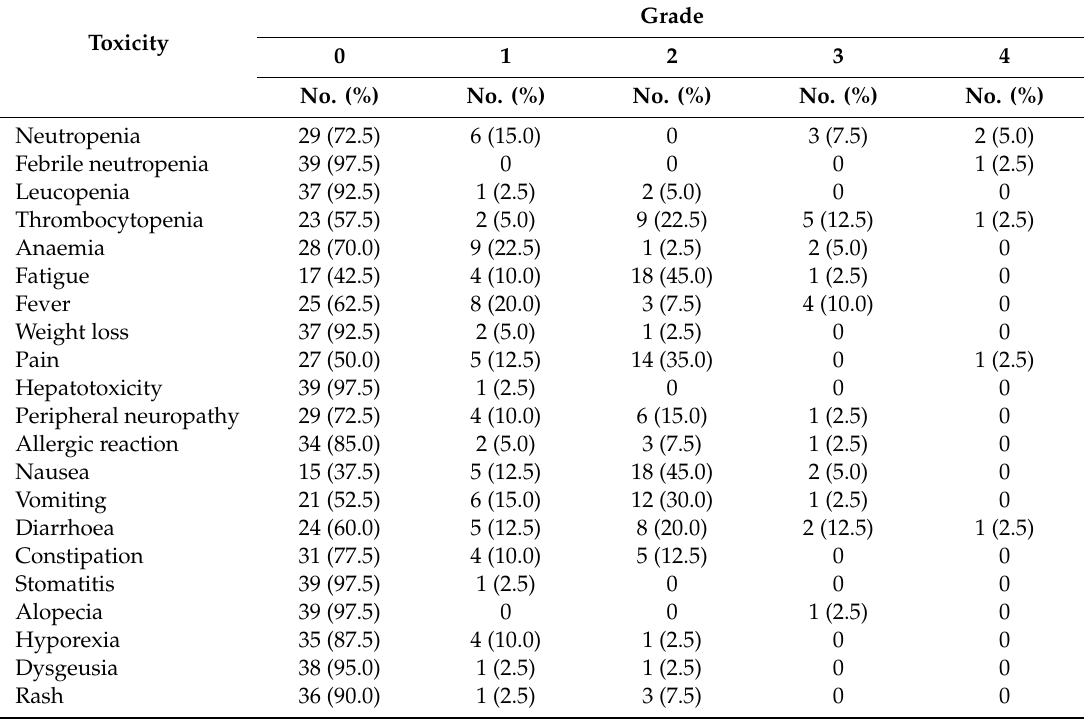
Table 2. Maximum toxicity in 40 patients treated with chemoradiotherapy (CTRT).